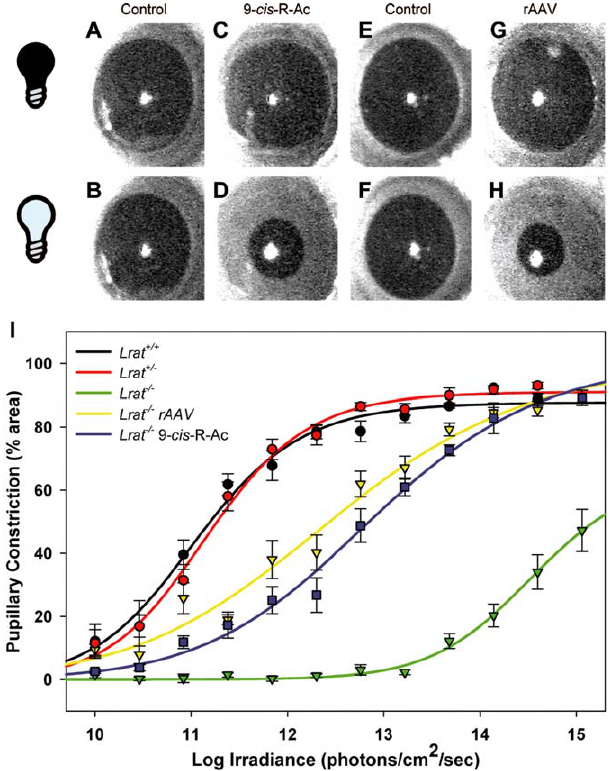
Figure 6. Light-Induced Pupillary Constriction of Lrat (cid:2) / (cid:2) Mice Before and After Treatment with 9- cis -R-Ac or rAAV- Lrat (A–H) 470 nm light (4.79 3 10 13 photons (cid:3) cm (cid:2) 2 (cid:3) sec (cid:2) 1 ) was used to stimulate pupillary constriction. Untreated Lrat (cid:2) / (cid:2) pupil before (A) and during (B) light exposure. Same mouse as in (A and B) subsequent to treatment with 9- cis -R-Ac, before (C) and during (D) light exposure. Control, untreated pupil of Lrat (cid:2) / (cid:2) mouse before (E) and during (F) light exposure. Contralateral eye of mouse shown in (E and F) treated with rAAV- Lrat , before (G) and during (H) light exposure. (I) Irradiance-response relations for PLR to 470 nm light. DOI: